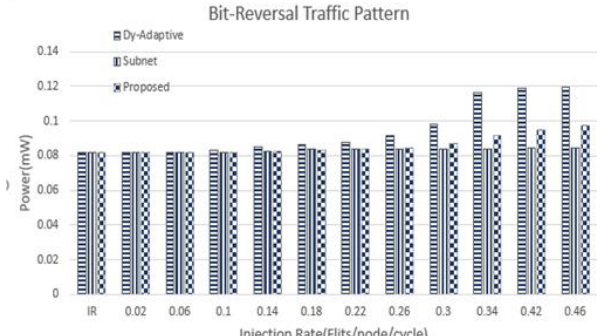
Fig. 18. Power consumption evaluation under synthetic Bit-Reversal traffic pattern Fig. 18 under bit reversal, the proposed algorithm